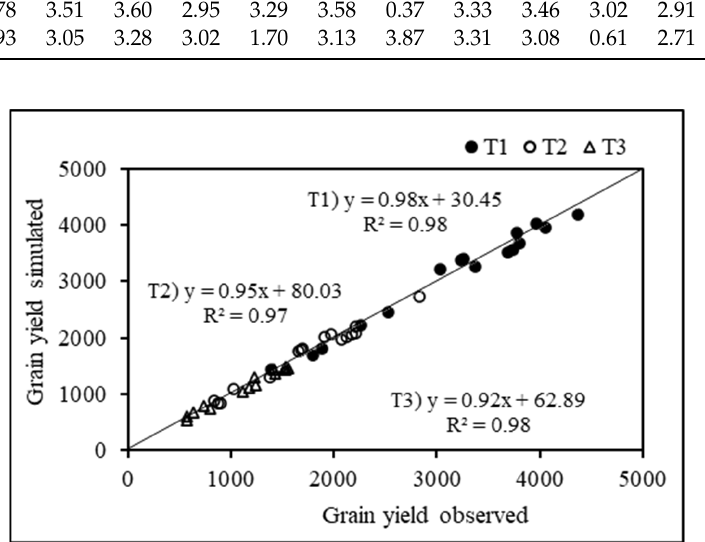
Figure 6. Comparison of the simulated versus observed grain yield (kg ha –1 ) for sixteen upland rice genotypes under T1: control (100% FC), T2: moderate stress (70% FC), and T3: severe stress (50% FC) treatments in the yield assessment experiment.